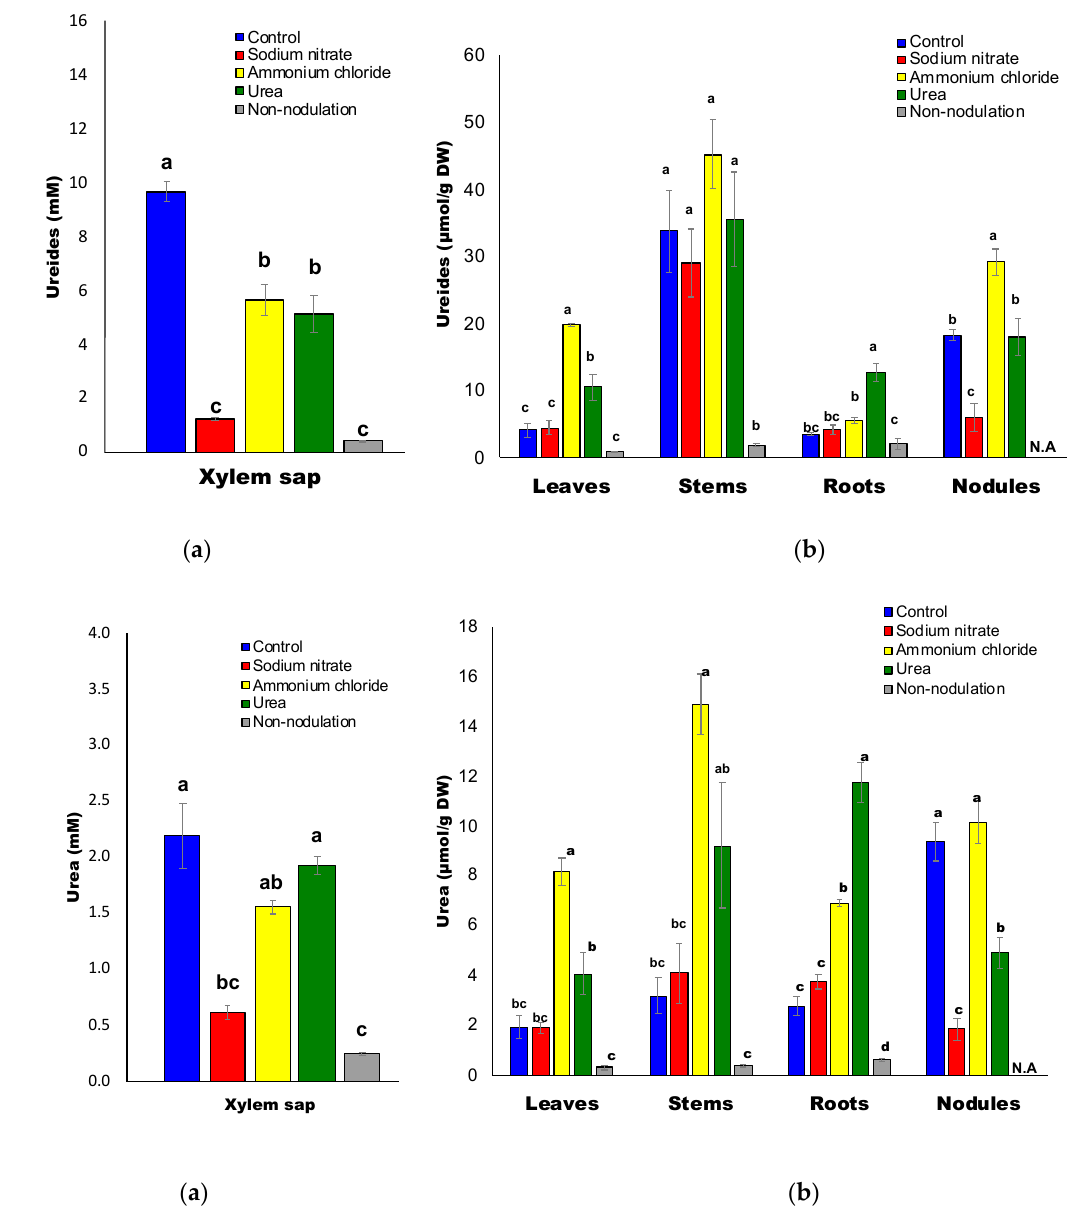
Figure 4. ( A ) Ureide concentrations in the xylem sap ( a ) and in each part ( b ) of the soybean plant. ( B ) Urea concentrations in the xylem sap ( a ) and in each part ( b ) of the soybean plant.